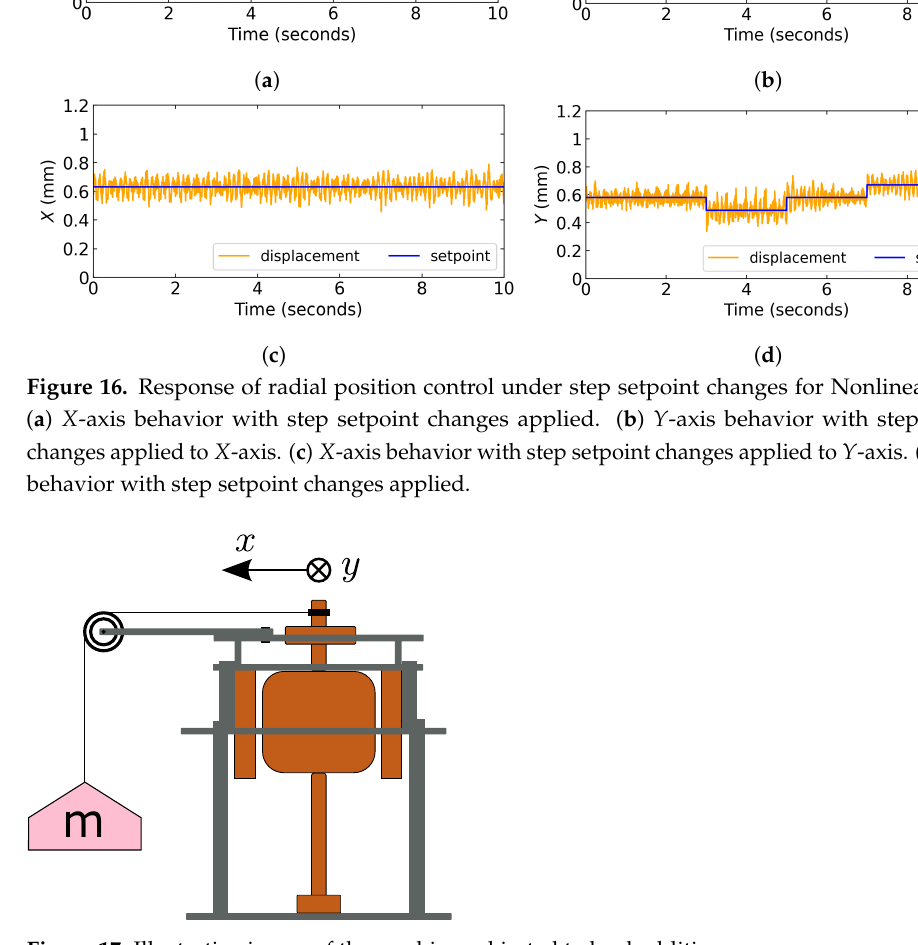
Figure 17. Illustrative image of the machine subjected to load addition. For each controller, the z 1 , z 2 , and z 3 states of the X and Y axes were collected in a time interval that allowed detecting the exact instant of addition of the radial load to the machine axis. Figures 18 and 19 show the behavior of the states of the X and Y axes for the two implemented controllers. In each graph, a green dashed vertical line was inserted to indicate the instant the application of 150 g of radial load aligned to the X -axis. This load was inserted in such a way that the radial load tends to move the radial position in the positive direction of the axis. Figure 18a,b show the state behavior of the linear controller. Visually, it is possible to state that there was a certain degree of rejection of the radial disturbance, but it is evident that the regime error of the X -axis increased after the moment of application of the load. The Y -axis remained stable. It is not possible to perceive variations in the z 3 state on the scale used because the linear controller was implemented with saturators at the observers’ output in order to avoid the Peak